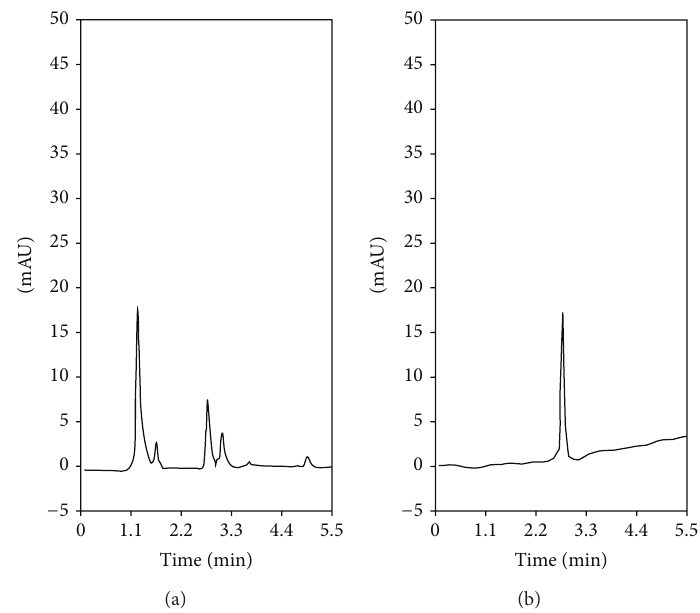
Figure 6: Chromatograms of (a) original sample and (b) eluted tartrazine solution after using MSPE developed